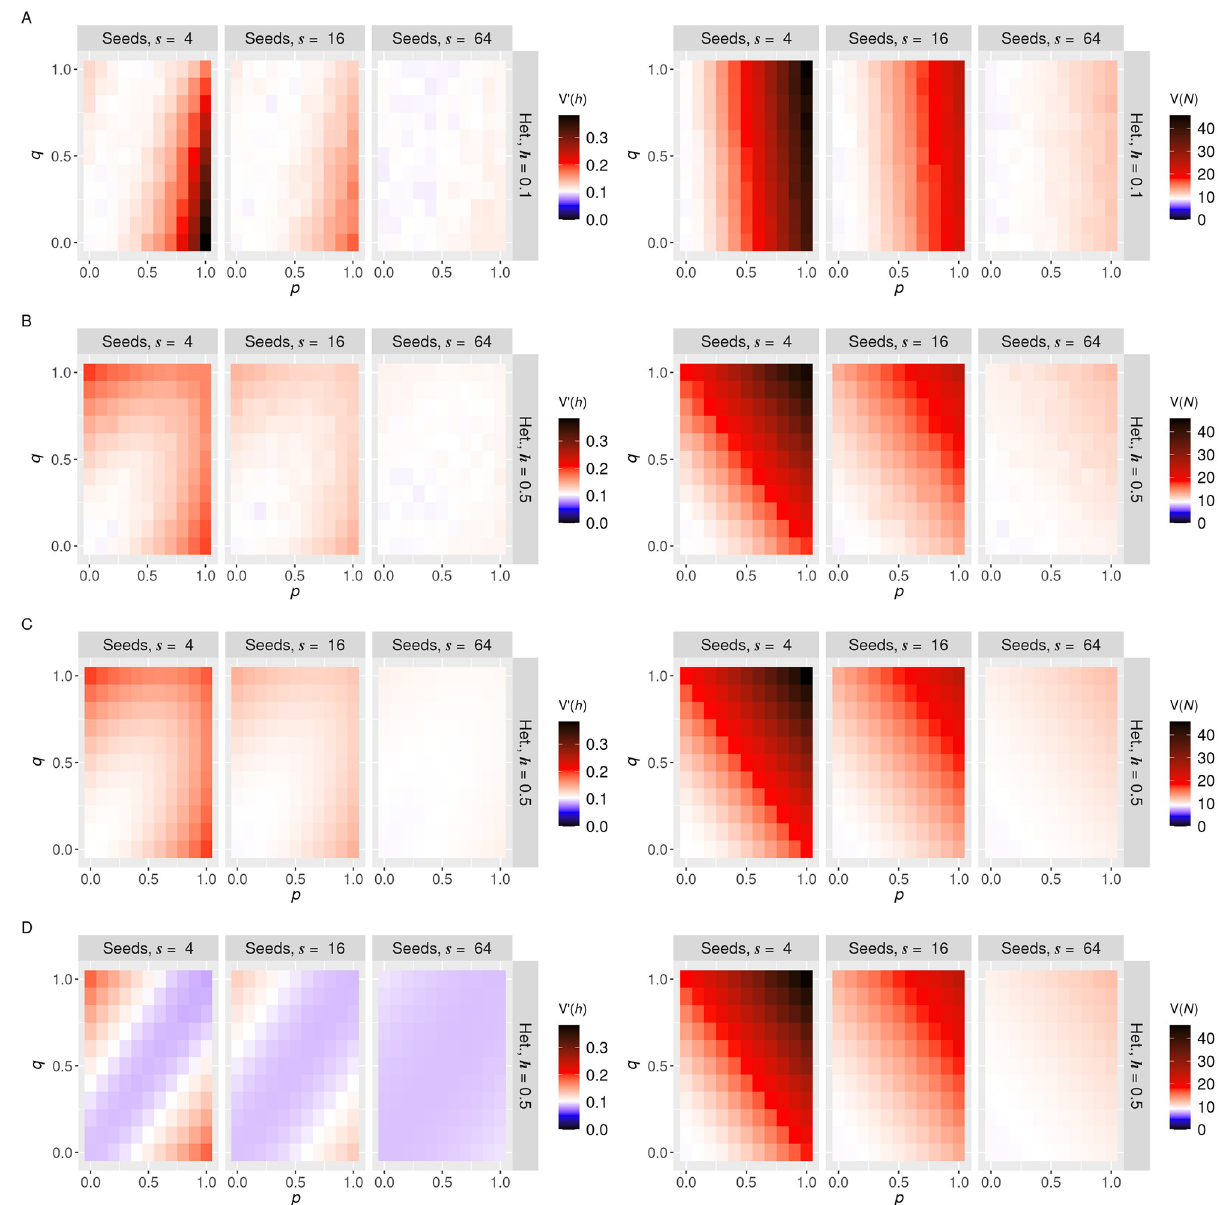
Fig 3. Asymmetric cell divisions can induce large cell-to-cell variability in mtDNA quality. Normalised heteroplasmy variance V 0 ( h ) (left column) and copy number variance V ( N ) (right column) for mtDNA randomly distributed in networks. The daughter of interest inherits 10% of the parent cytoplasm. A : simulations for h = 0.1; B : simulations for h = 0.5; C : sum over state variables; D : first-order Taylor expansion. The three columns for each panel give decreasing network heterogeneity, expressed via different seed numbers, 4, 16 and 64 (more seed points give a more homogeneous network). In each panel, variances are given for different values of wild and mutant type network inclusion parameters p (horizontal axis) and q (vertical axis). White baseline reflects the null case from the analytic sum without any network inclusion. difference in inclusion probabilities for the different types of mtDNA. For p 6¼ q , the network is genetically biased towards one of the types, to which there is associated an increase in V 0 ( h ). For p = q , the network is unbiased, with associated prediction V 0 small negative change from the binomial case. However, this negative shift is in fact an artefact